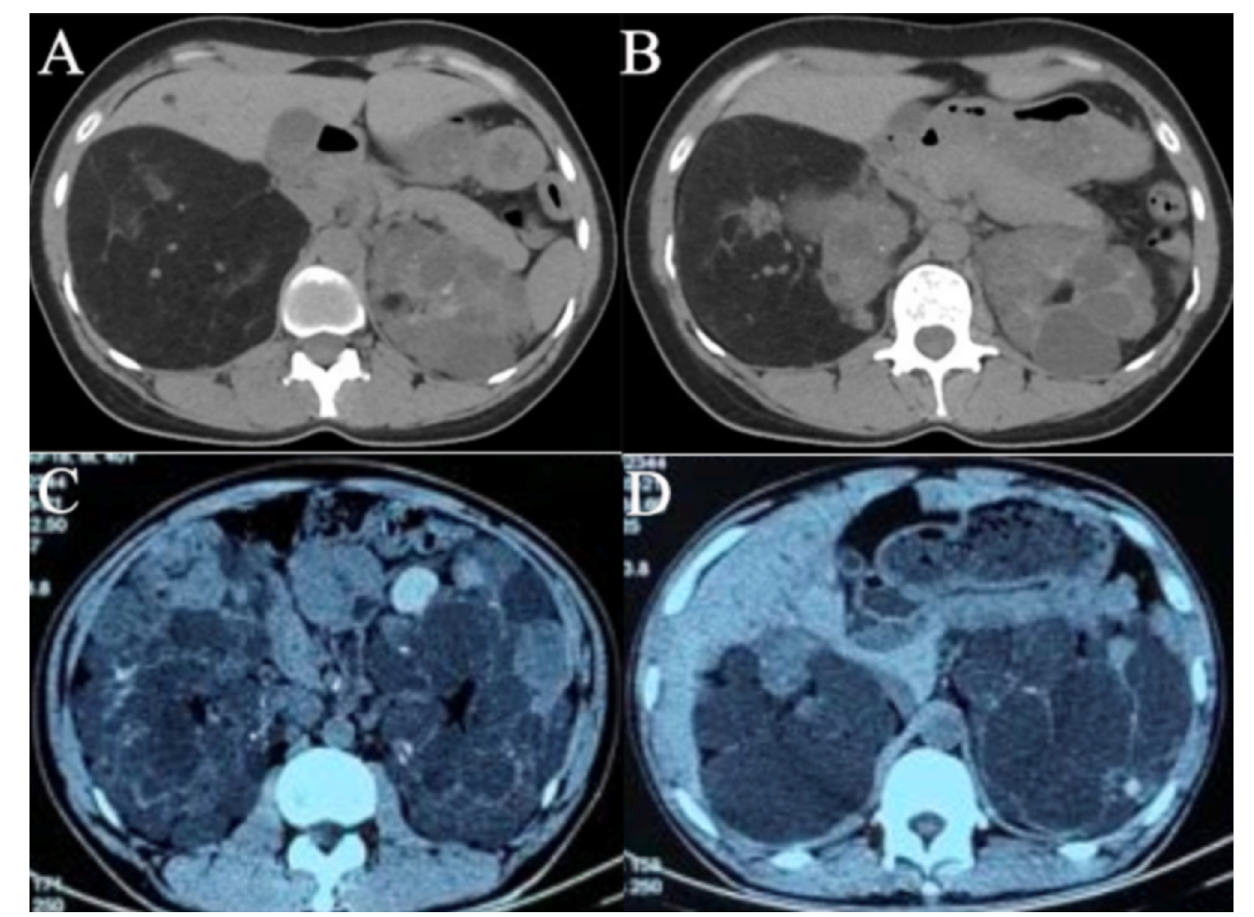
Figure 2 - Computed tomography (CT) exam results: A and B, in a 35-year-old female patient with TSC2 EX2_42 DEL (had both TSC2 and PKD1 mutations), left kidney with multilocular cysts typical of polycystic kidney disease (PKD), and right kidney presenting a huge angiomyolipoma (AML) with a maximal diameter of 106mm; C and D, in a 40-year-old male patient with the same genetic variant, the presence of PKD bilaterally, without any specific signs of AML.